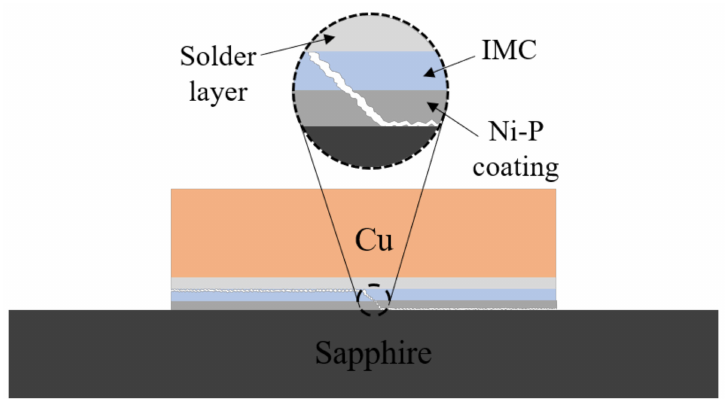
Figure 9. Cu/solder/sapphire fracture schematic